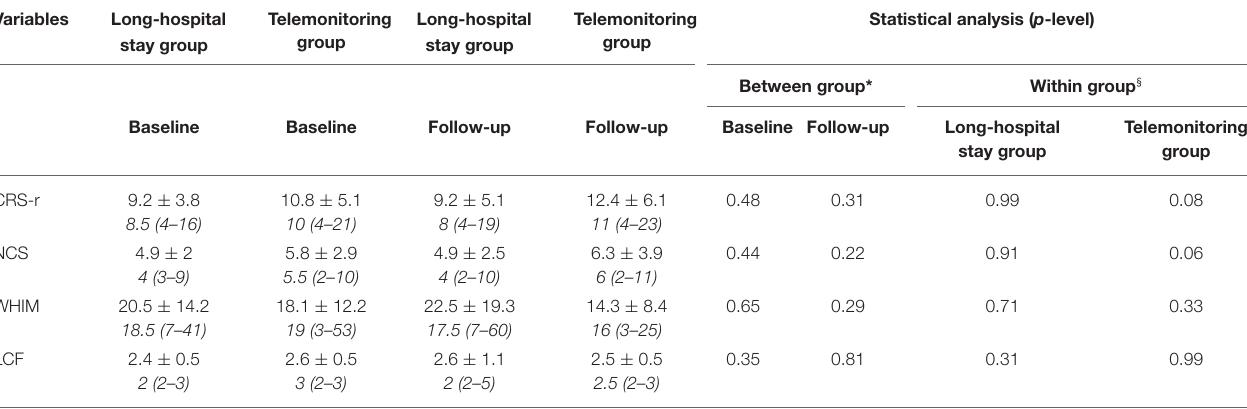
TABLE 3 | Clinical outcome of TBI patients at admission and after follow-up. Variables